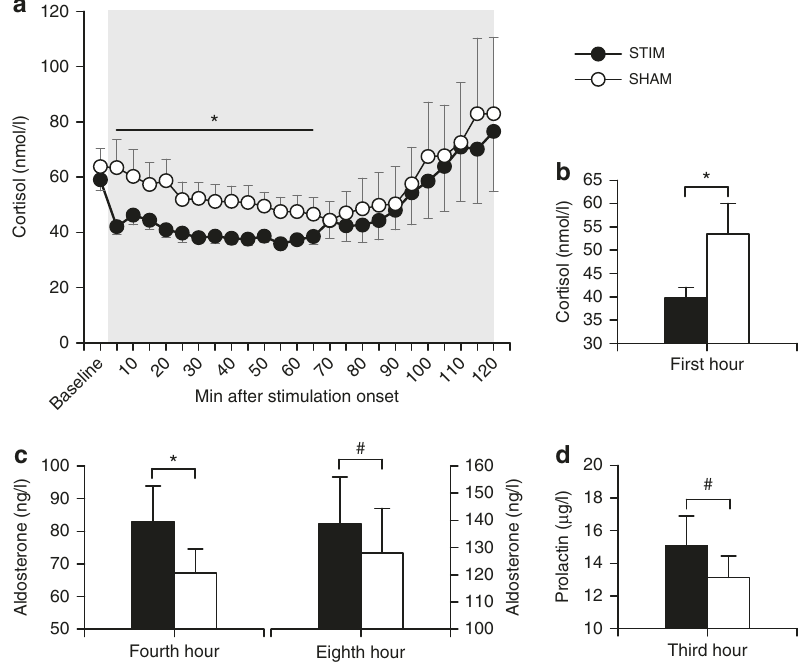
Fig. 2 Impact of auditory SO stimulation on cortisol, aldosterone, and prolactin levels. Means ( ± s.e.m.) of cortisol ( a , b ), aldosterone ( c ), and prolactin ( d ) levels calculated for 1-h bins. Gray area represents the 120-min stimulation period. * p < 0.05, # p < 0.1 for pairwise comparisons between the Stimulation condition (STIM, black) and the Sham condition (SHAM, white) with Wilcoxon tests, two-sided. n = 10 – 14 (see “ Methods ” section for exact numbers)